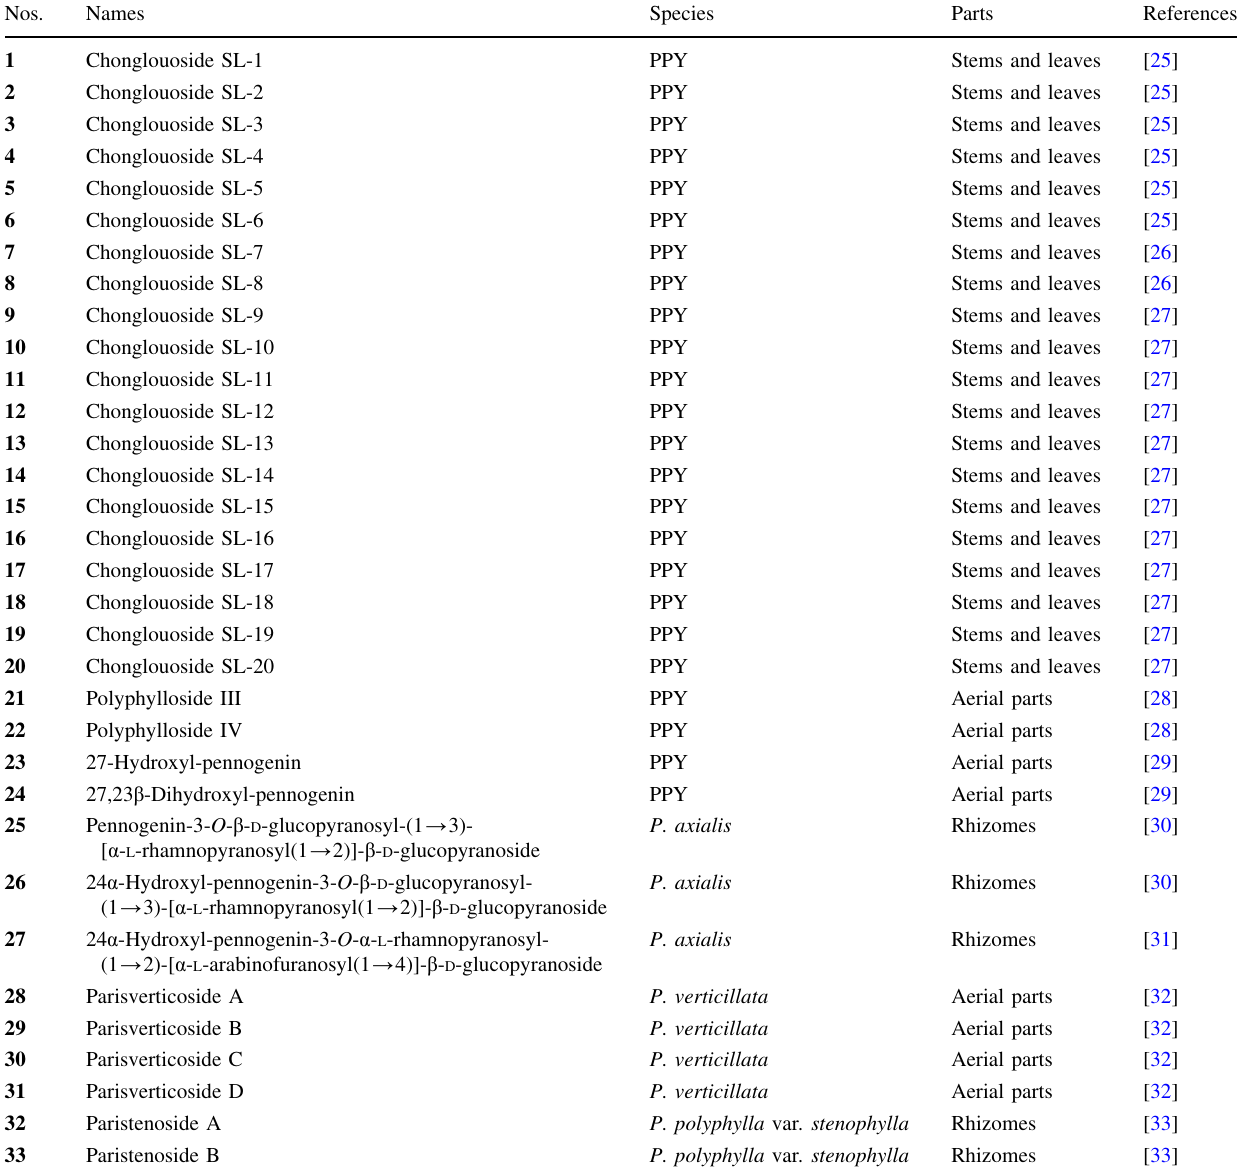
Table 1 New steroidal sapogenins and saponins from non-medicinal parts of PPY and other Paris species